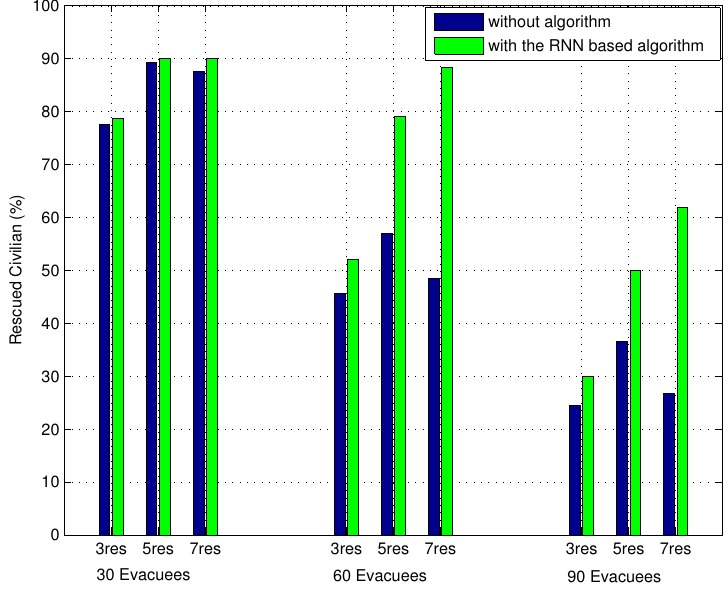
Figure 3. Percentage of evacuees saved by rescuers under diverse population densities.